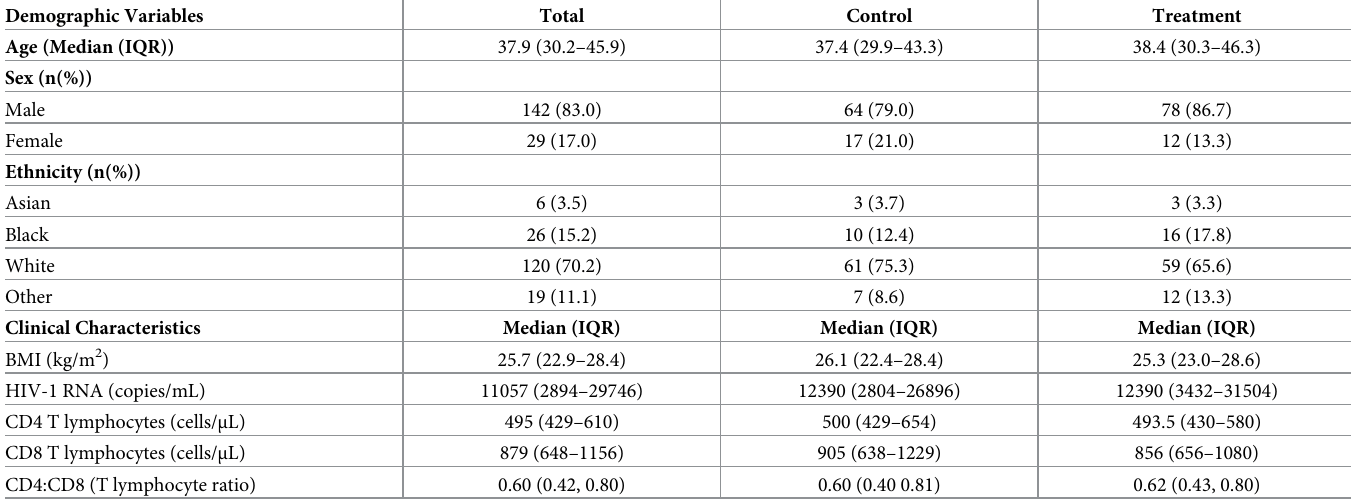
Table 2. Demographic and clinical characteristics for randomized participants at baseline (n =